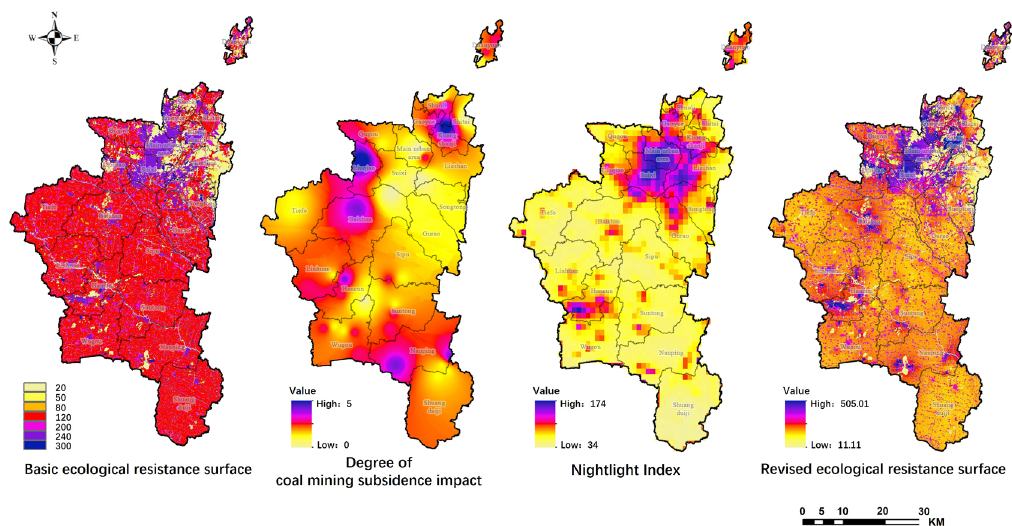
Figure 6. Spatial distribution of ecological resistance surface.